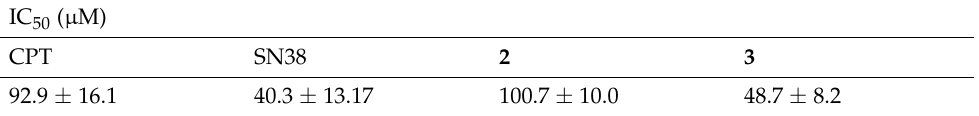
Figure 9. The inhibition of human Topo I relaxation activity with regard to increasing concentrations of campthotecin (CPT), SN-38 and new Topo I poisons 2 and 3. The mean and SD are presented on a graph. Table 6. The IC 50 indices—the concentration required to reduce the relaxation Topo I activity by